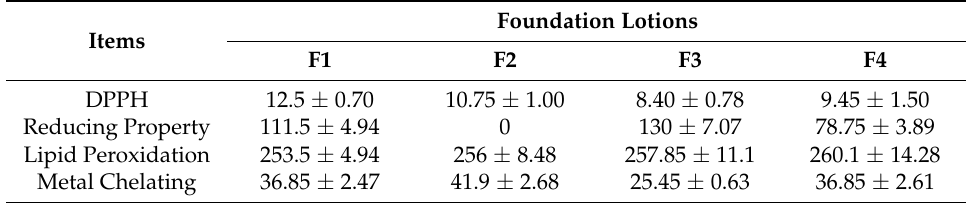
Table 2. Comparison of IC50 of ethanol extract of four facial foundation lotions in relation to antioxidant potential. IC50 value is expressed in µ g/mL. Results are represented as mean ± standard deviation of three independent